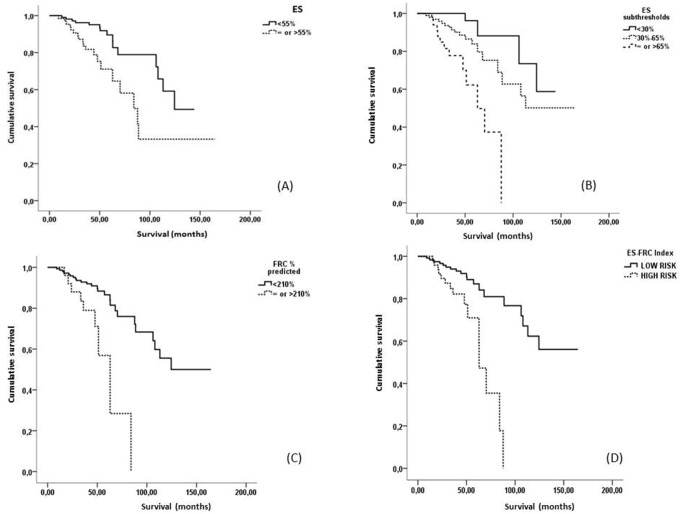
Kaplan Meier curves for the COPD population, categorized according to A) ES optimal threshold of 55%, B) ES subthresholds of 30 and 65%, C) FRC % predicted optimal threshold of 210% and D) ES-FRC composite index.